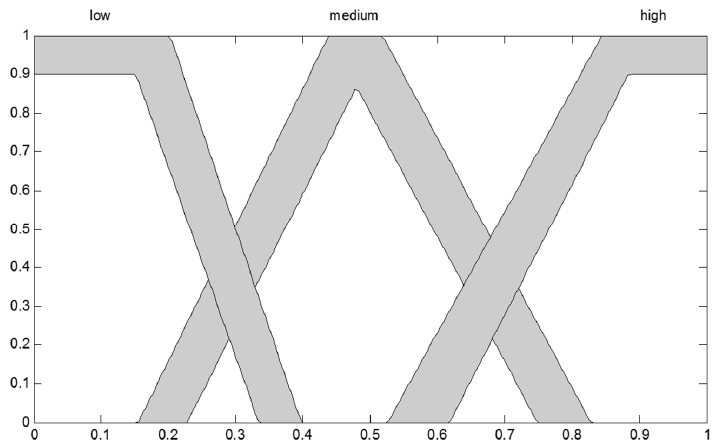
Figure 4. Input variable iteration.